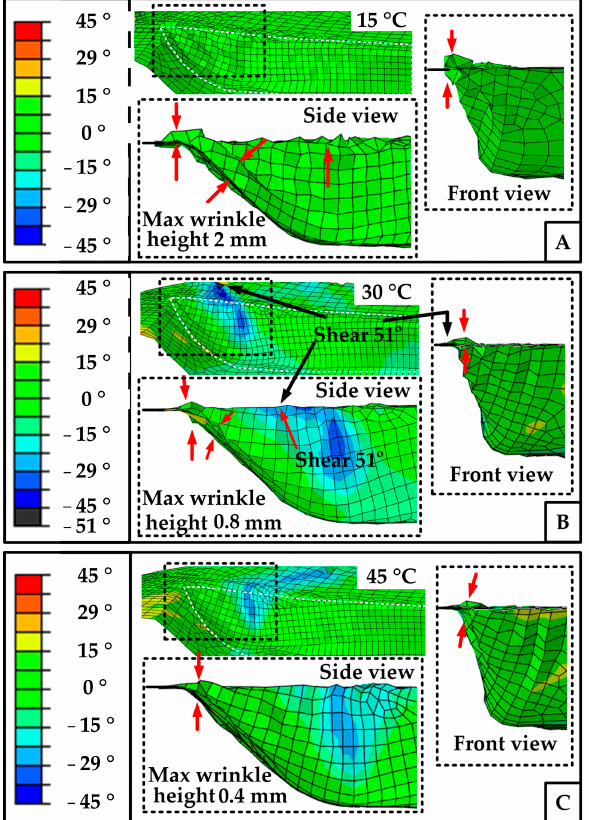
Figure 19. The wrinkle distribution of simulations: ( A ) the side view and front view of corner material at 15 °C; ( B ) the side view and frontview of corner material at 30 °C; ( C ) the side view and front view of corner material at 45 °C.